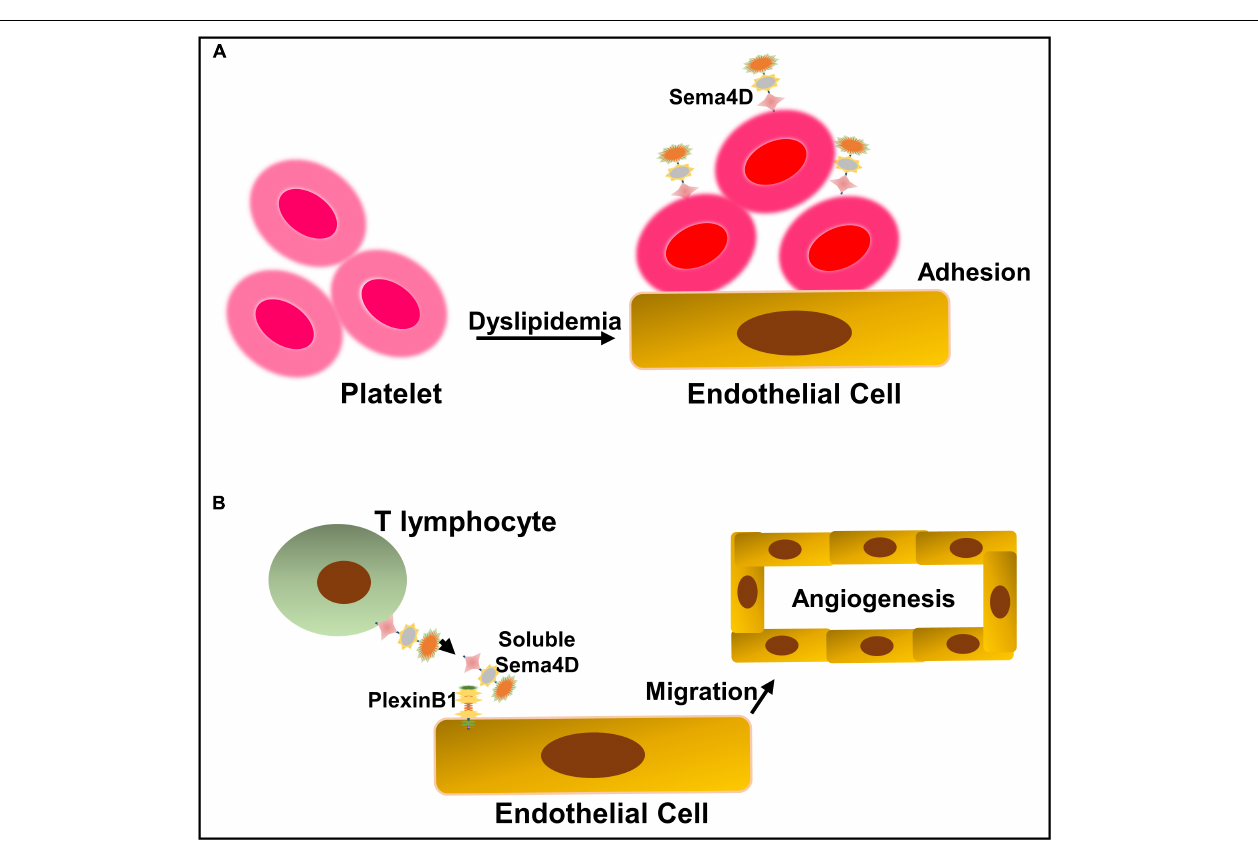
FIGURE 4 | Schematic representation of Sema4D and its receptor PlexinB1 in the development of atherogenesis. (A) Dyslipidemia upregulates platelet sensitivity, making them more likely to become activated in response to vascular injury. Sema4D enhances platelet hyperactivity, which may lead to platelet adhesion and transmigration into the intima, thus accelerating the development of atherosclerosis. (B) Sema4D expresses on the surface of invasive lymphocytes in atherosclerotic lesions and interacts with PlexinB1 on the endothelial cells, resulting in endothelial cell activation, macrophage infiltration, and intraplaque